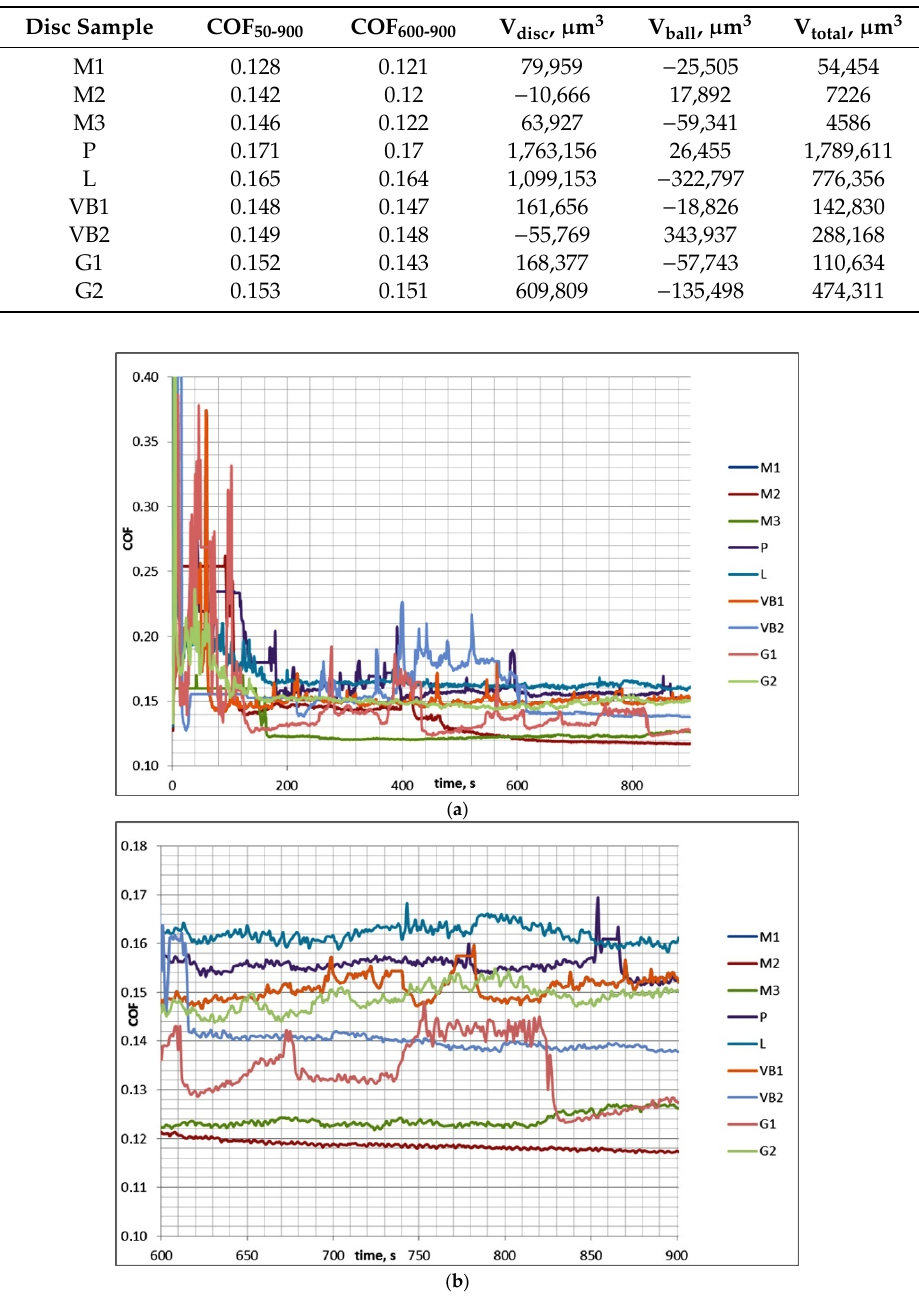
Figure 4. Friction coefficients for the whole test A ( a ) and for its last 5 min ( b ).